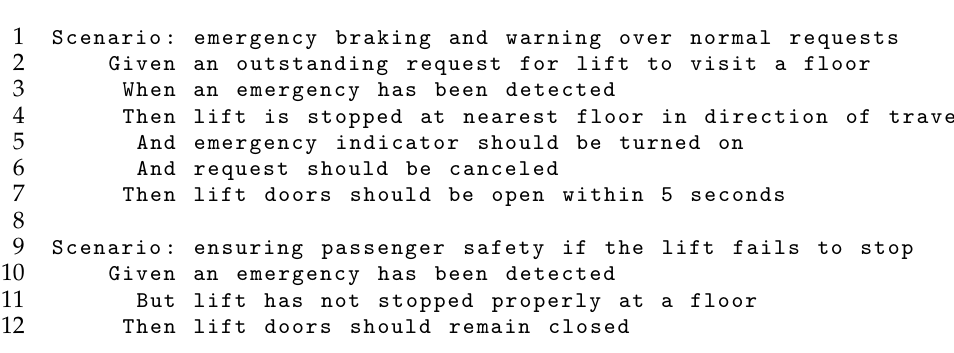
Figure 3. Lift operations: safety over serving normal requests in case of an emergency.